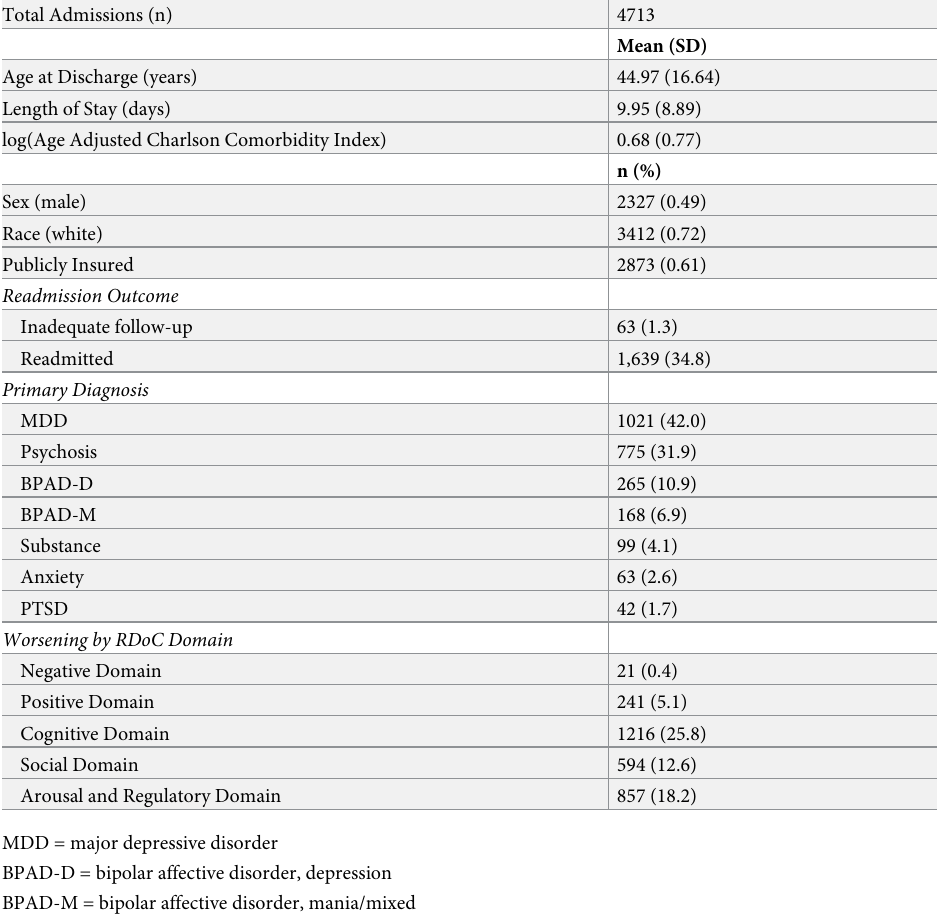
Table 1. Characteristics of all